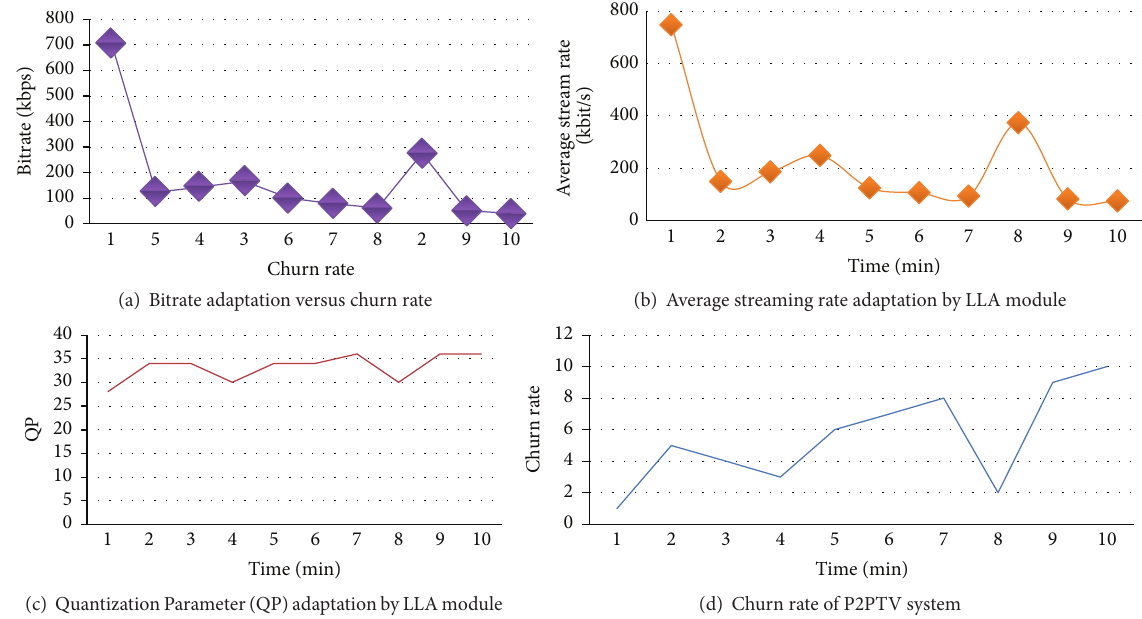
Figure 11: Bitrate, average streaming rate, and Quantization Parameter (QP) adaptation by LLA with churn rate of peers in the P2PTV